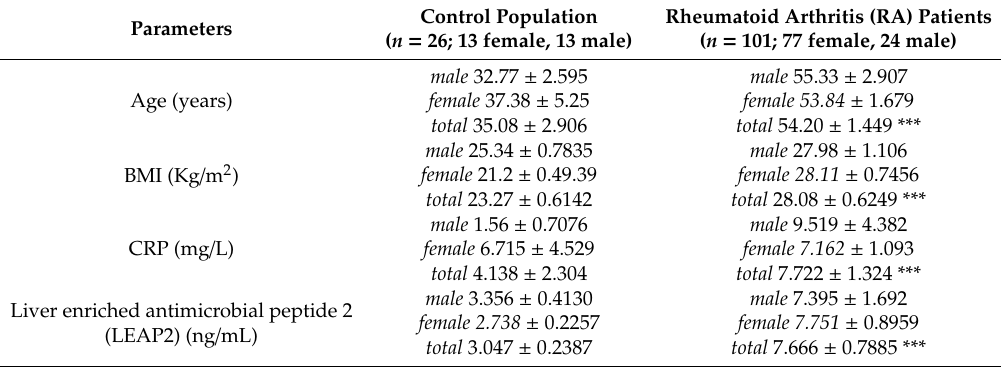
Table 1. Anthropometric and laboratory characteristics of the studied groups.